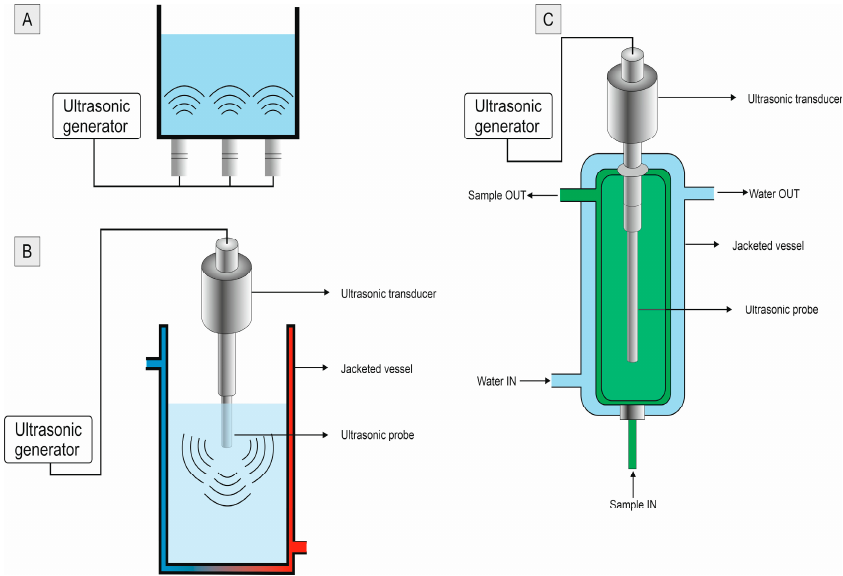
Figure 1. Most common ultrasonic setups: ( A ) bath with probes mounted bellow: ( B ) directly immersed probe: ( C ) continuous flow sonication with cooling.